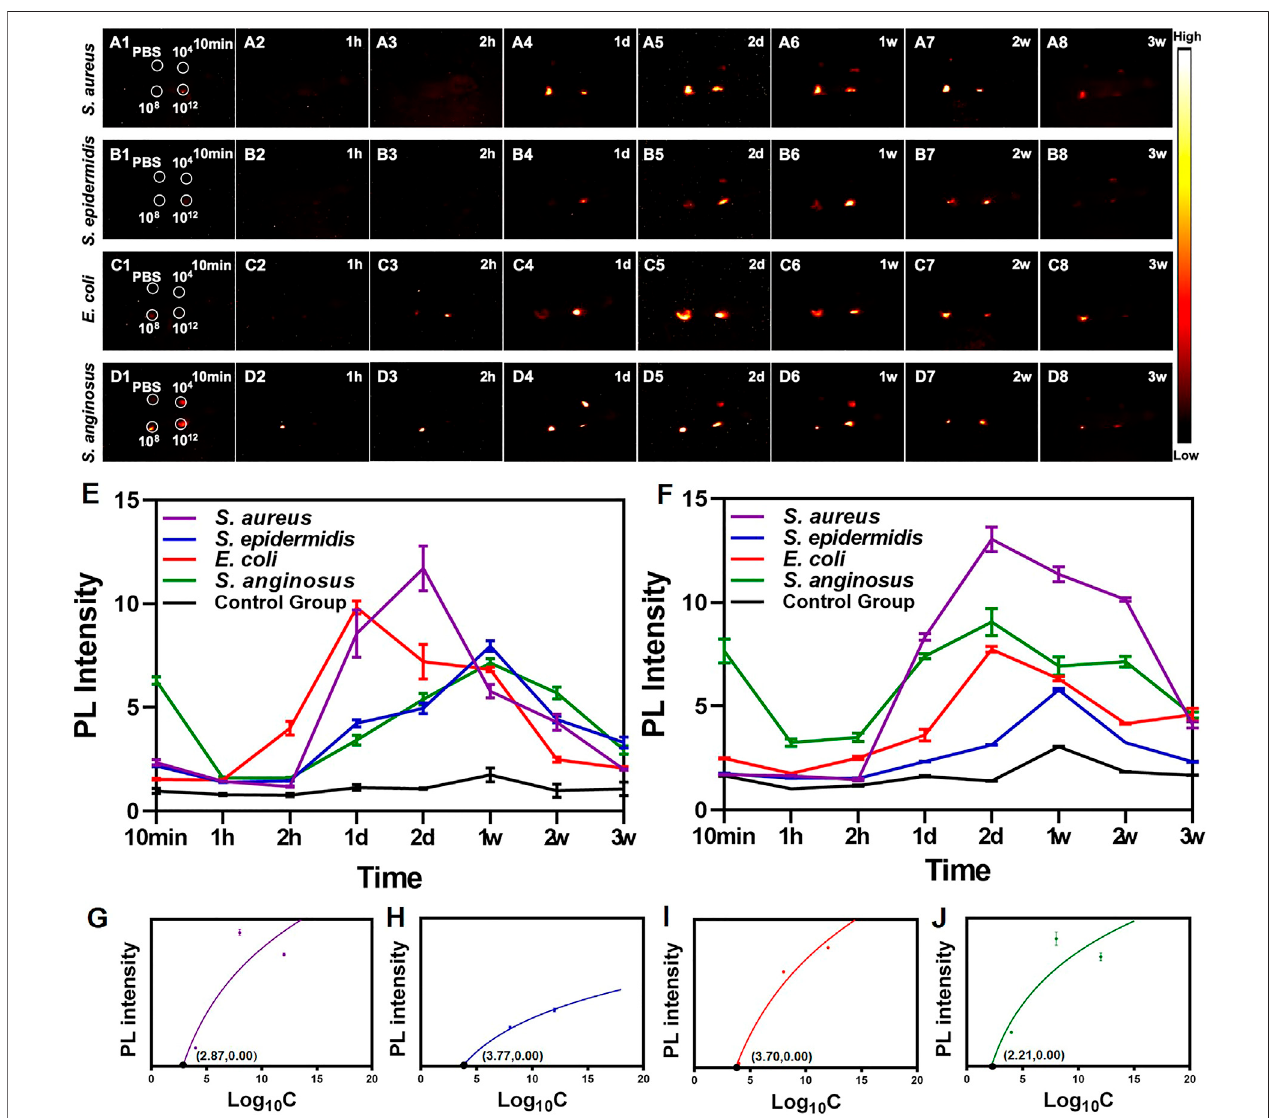
FIGURE3| (A – D) NIR-II images of nudemice at 10 min, 1 h, 2 h, 1 day,2 days, 1 weeks,2 weeksand 3 weekspost-infection. (E) PL intensity ofthe site injected with 10 12 CFU/ml of bacteria. (F) PL intensity of the site injected with 10 8 CFU/ml of bacteria. Graphs depicting the relevance between PL intensity and different concentration of four strains of bacteria including (G) S. aureus , (H) S. epidermidis , (I) S. anginosus and (J) E. coli .